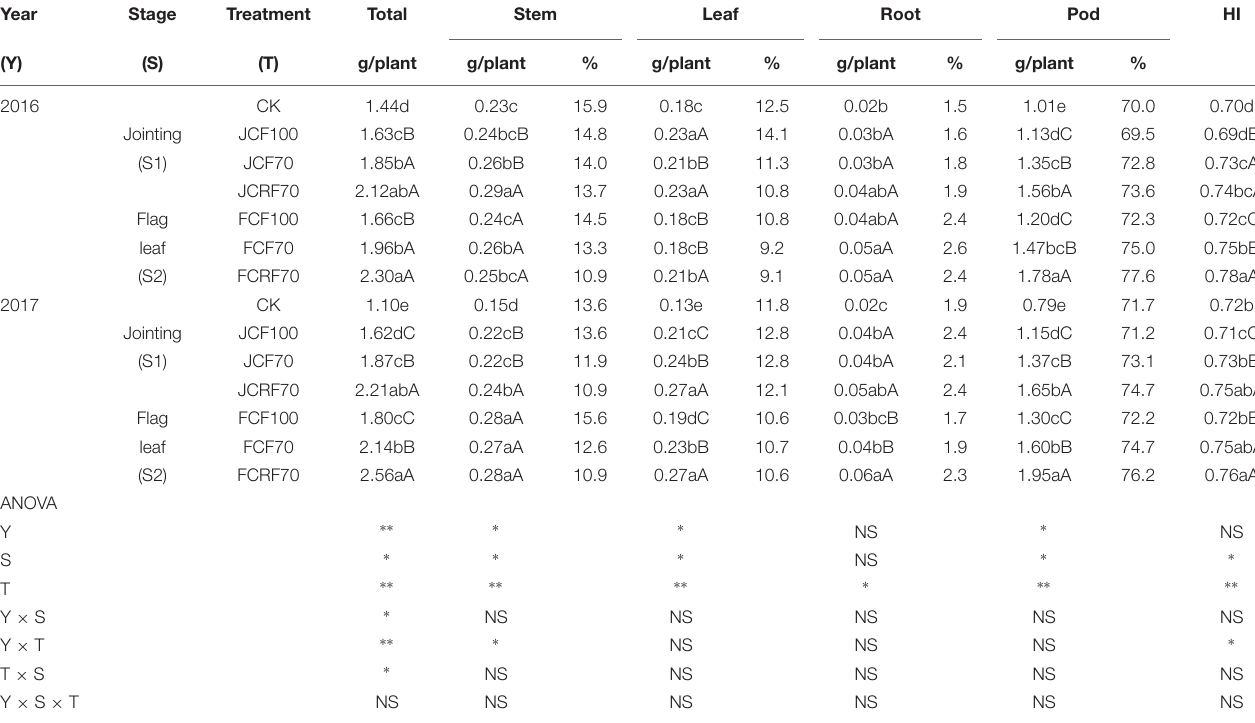
TABLE 5 | Effect of different N fertilizer management regimes on N accumulation (g plant − 1 ) and distribution (%) in peanut at the maturity stage.